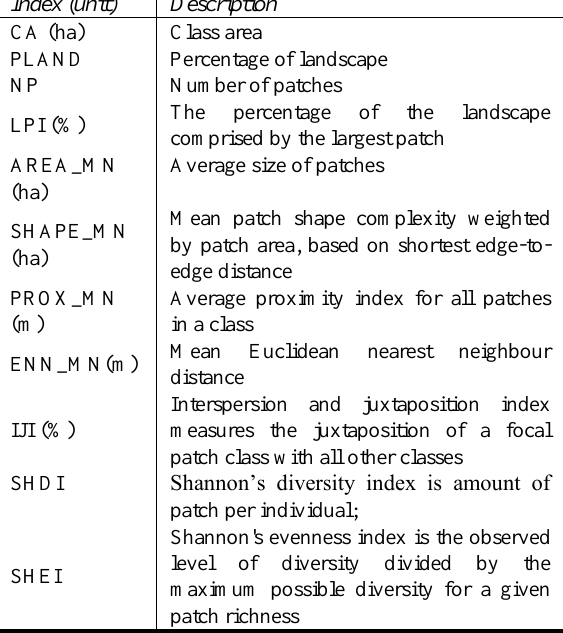
Figure 2. Areas land use/cover classes of Danang city Table 2. Landscape pattern metrics description (McGarigal, To provide a further comprehensive calculation in losing and 2002, Keleş et al. , 2008) gaining among the six LULC classes, the from-to change matrix of land use/cover in Danang city were created in three intervals, 1979-2003, 2003-2009 and 1979-2009(Table 4). In cross tabulation, unchanged pixels were located along the major diagonal of the matrix while conversion values of classes were arranged in descending order. As can be seen from the Tables 3 and 4, there were small differences of area coverage of a particular class because of used different spatial resolutions for calculating LULC change from 2003 to 2009. In fact, the 2009 ASTER image was resampled to a spatial resolution of 30m.